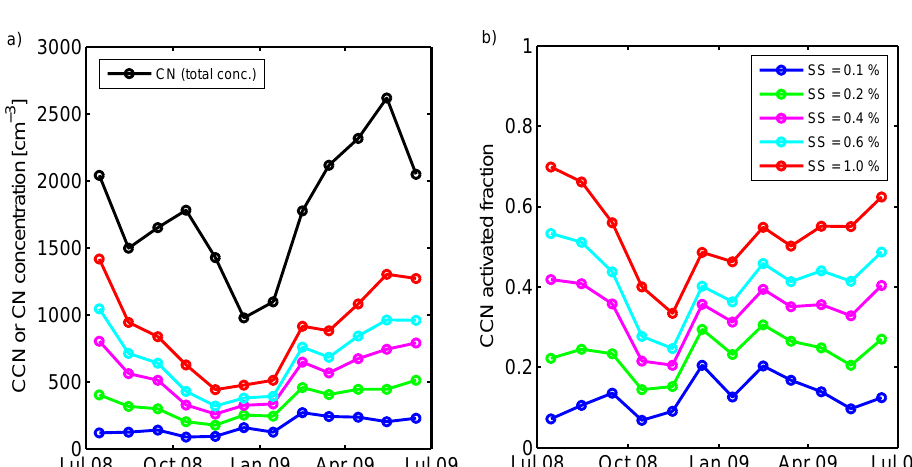
Fig. 2. (a) Monthly mean values of the CCN concentrations at different supersaturations and the total number concentration (CN), and (b) monthly means of the activated fraction